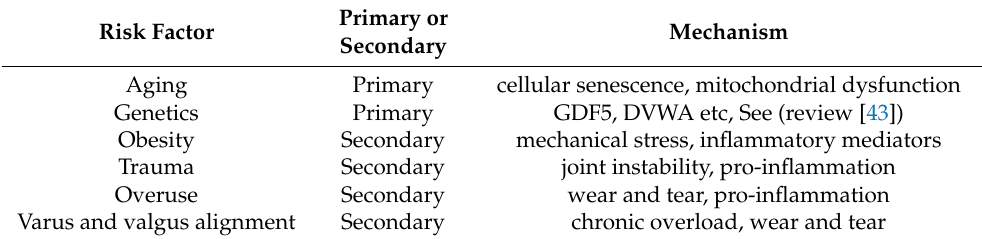
Table 1. Causes of osteoarthritis (OA) pathogenesis in human